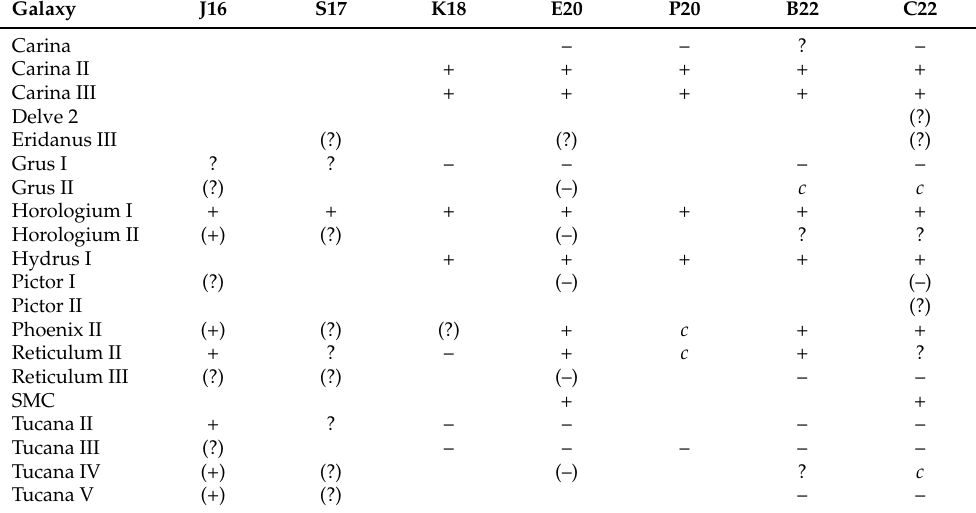
Table 1. Possible satellites of the LMC, according to several studies: Jethwa et al. [55], Sales et al. [59], Kallivayalil et al. [60], Erkal and Belokurov [34], Patel et al. [61], Battaglia et al. [62], Correa Magnus and Vasiliev [37]. Highly likely, uncertain, unlikely, and recently captured/interacted satellites are denoted by +, ?, –, and c , respectively. Objects in brackets lacked line-of-sight velocity measurements at the time of writing of the corresponding paper, but are consistent with being satellites for some values of velocity (note that all objects in J16 and S17 also lacked PM